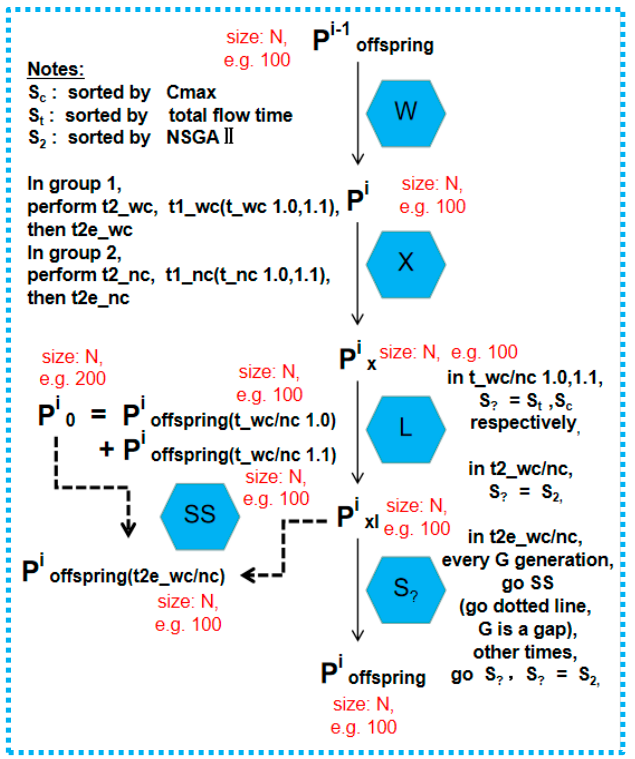
Figure 2. The overview [5] of the SMO pipeline is above. The abstract framework behind the overview actually is the same as “Meets”, “eMeets” and “iMeets”. In the pipeline, we take generation i as an illustration, the flow is from parent P i to P i offspring . During the flow, it undergoes a clustering operator W, a crossover operator X, a local search operator L and selection operators.